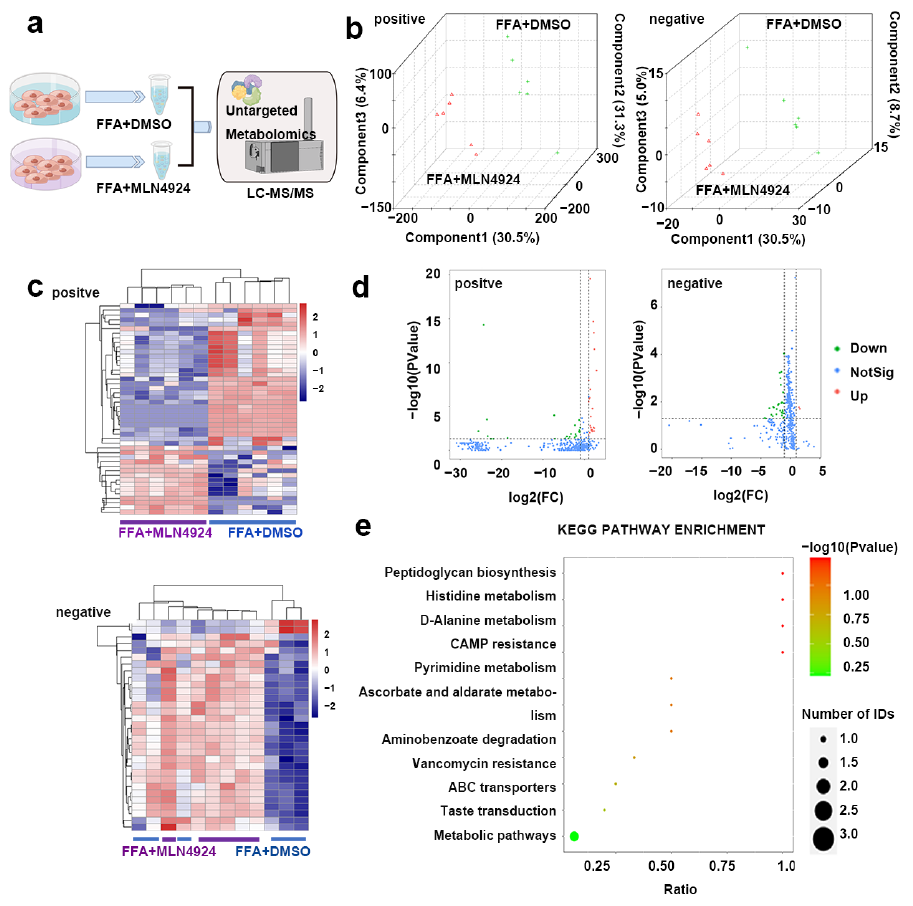
Figure 7. Lipidomics analysis on liver lipid metabolism after treatment of neddylation inhibitor MLN4924. ( a ) Huh7 cells were divided into FFA + DMSO and FFA + MLN4924 groups. LC-MS– based nontargeted metabolomic analysis detecting differential metabolites between two groups ( n = 6 per group). ( b ) PLS-DA three-dimensional score plots for FFA + DMSO and FFA + MLN4924 groups. Images showed global sample distribution profiles analyzed by PLS-DA with the positive ion mode on the left and negative ion mode on the right. ( c ) Heatmap presented differentially expressed metabolites in FFA + DMSO group and FFA + MLN4924 group with the positive ion mode above and negative ion mode below. ( d ) Volcano plot showed lipidomics analysis of FFA + DMSO group and FFA + MLN4924 group with the positive ion mode on the left and negative ion mode on the right. The red dot represented the fold change (FC) > 2.0 and p value < 0.05. The green dot represents FC < 0.5, and p value < 0.05. ( e ) KEGG pathway enrichment analysis presented the main metabolic pathways identified between FFA + DMSO group and FFA + MLN4924 group by metabolites annotated to KEGG